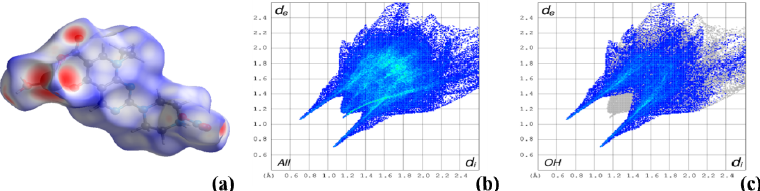
Figure 6. Hirshfeld surface analysis for complex I ( a ) and 2D fingerprint plots for the full interactions ( b ) and for the O-H interactions ( c ), similar results for complexes II and III .